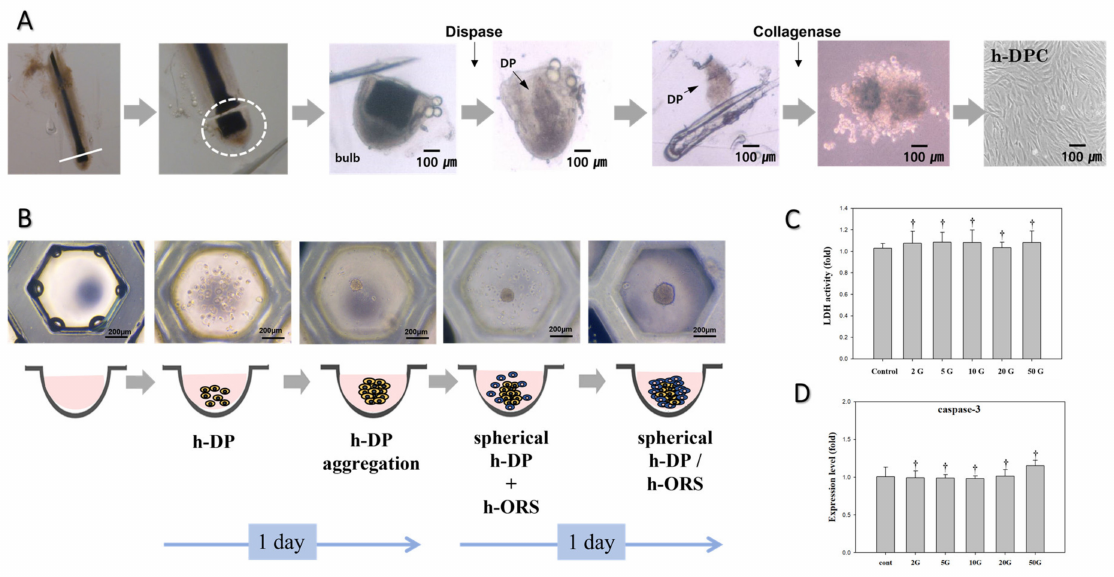
Figure 2. ( A ) Isolation of DP cells from hair follicles. ( B ) Establishment of the hair bulb spheroid (HBS) in vitro model consisting of human DP and ORS cells. ( C ) Evaluation of the cytotoxic effects of various ELF-EMF intensities (2, 5, 10, 20, and 50 G) on HBSs. Cytotoxicity was measured using the LDH assay kit. ( D ) Effects of various ELF-EMF intensities (2, 5, 10, 20, and 50 G) on HBS apoptosis. Apoptosis was measured via qPCR analysis of caspase-3. Each bar represents the mean ± standard error of independent experiments performed in triplicate ( n = 3). Significant differences were determined via one-way ANOVA with Tukey’s post hoc test; † p > 0.5 compared to the control. Original magnification: 100 × . Scale bar: 200 µ